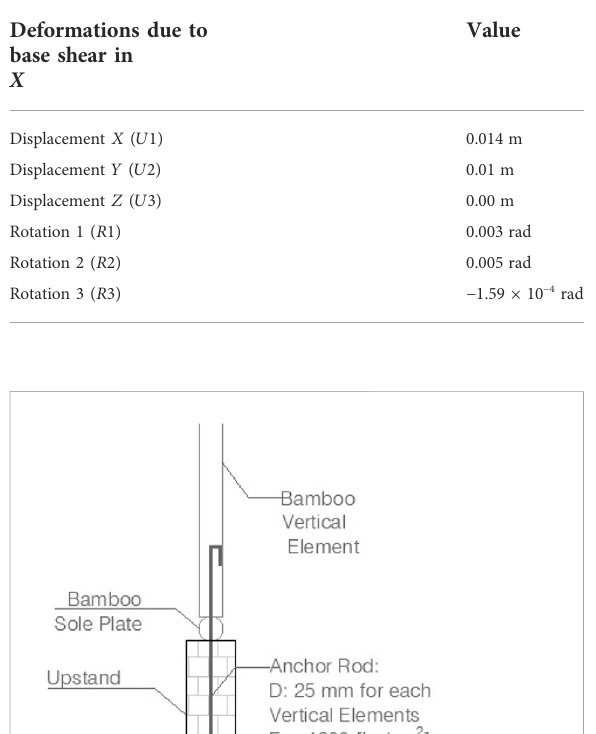
TABLE 7 Maximum deformations presented due to the action of the seismic load.